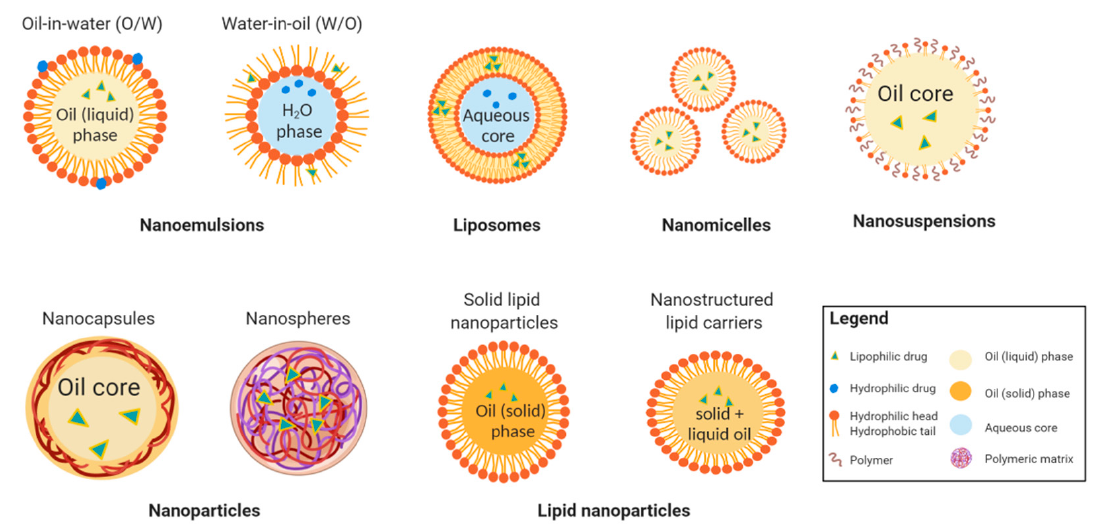
Figure 3. Schematic representation of nanotechnology-based drug delivery systems for ocular diseases (created with BioRender.com).